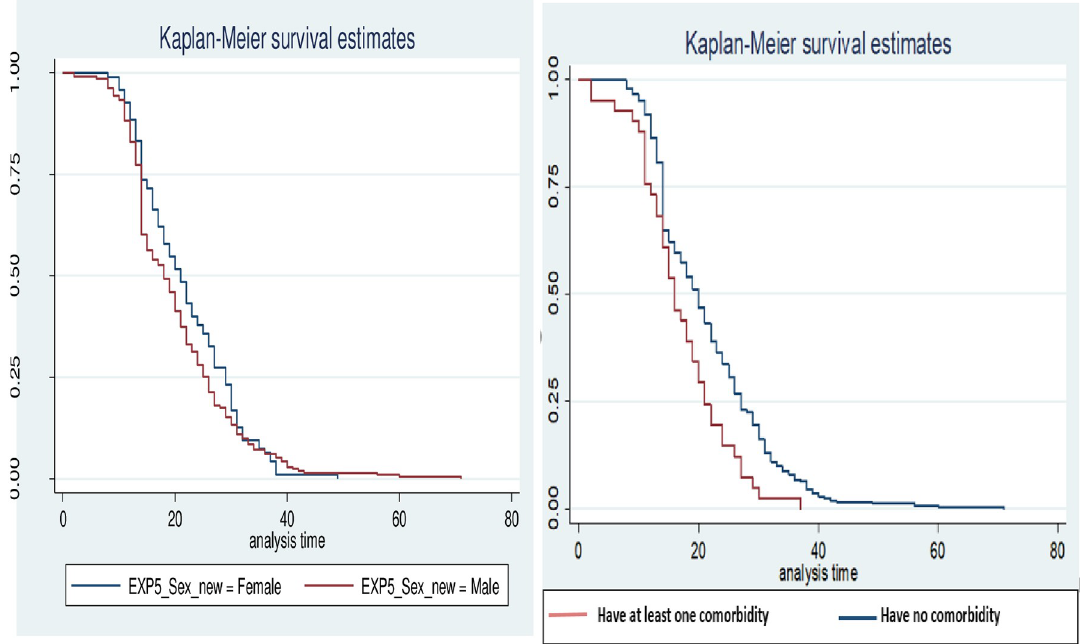
Fig 3. Kaplar-Meier survival estimate by comorbidity and